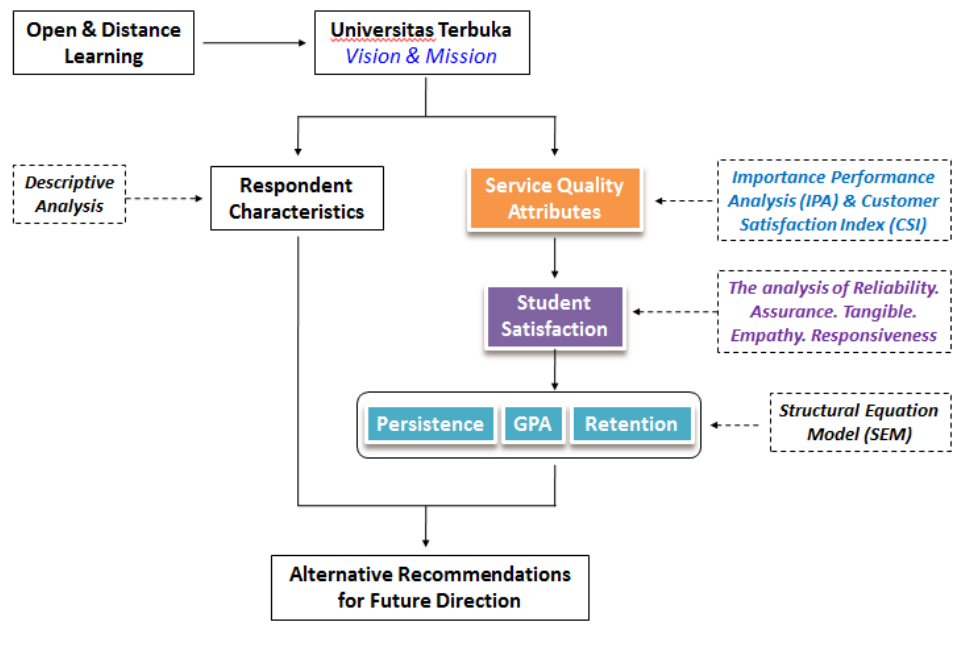
Figure 1 Conceptual framework of the